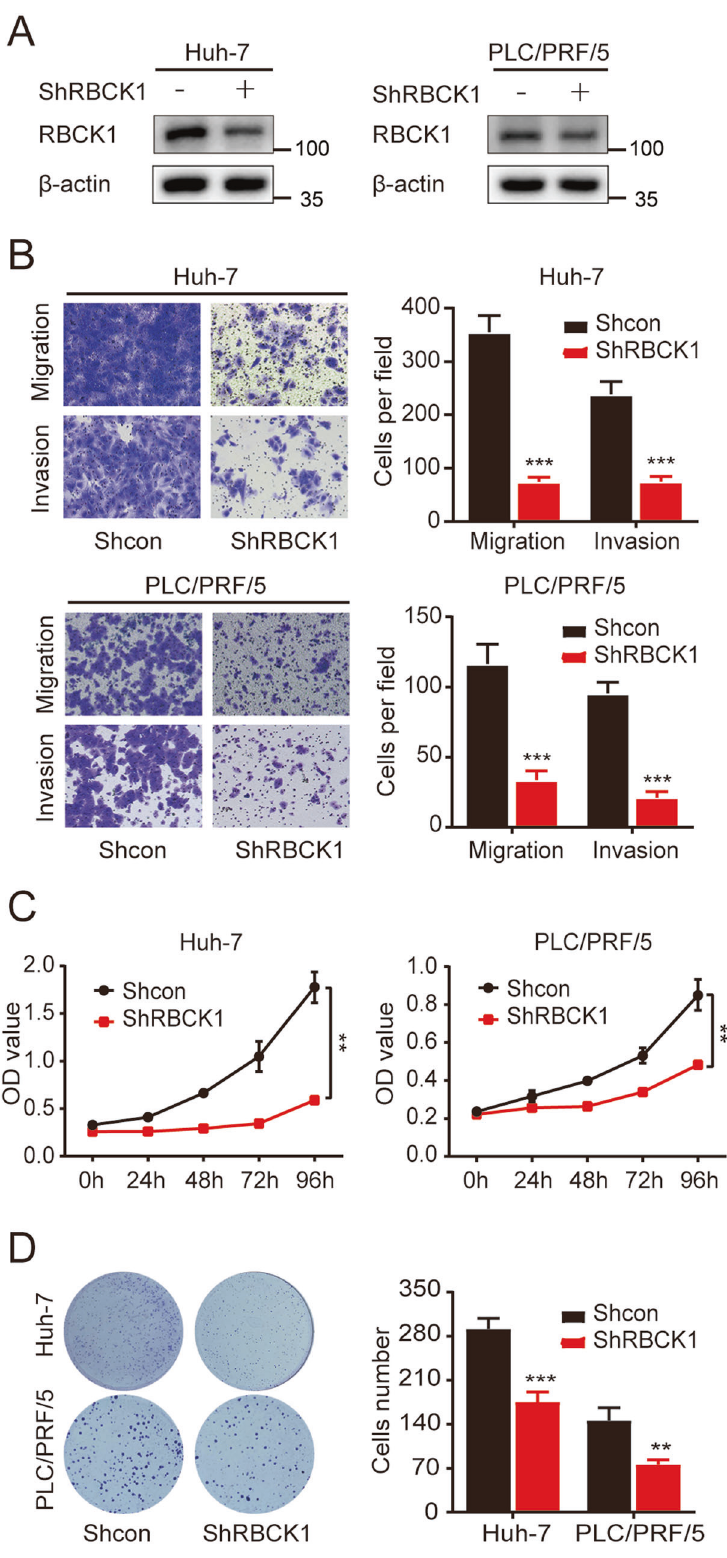
Fig. 5 RBCK1 knockdown inhibits the migration, invasion, and proliferation of HCC cells. A Knockdown ef fi ciency of RBCK1 in PLC/PRF/5 and huh-7 cells was con fi rmed by western blot. B Representative images of transwell migration and invasion assays for the RBCK1 knockdown and control HCC cells. The cells were counted under the microscope at ×100 magni fi cation in fi ve randomly selected single fi elds of vision. C CCK-8 assay was conducted to evaluate the effect of RBCK1 knockdown on PLC/PRF/5 and huh-7 cells proliferation. D Clone formation capacities of the control and RBCK1 knockdown PLC/PRF/5 and huh-7 cells were assessed by the clone formation assay. (** p < 0.01, *** p < 0.001).